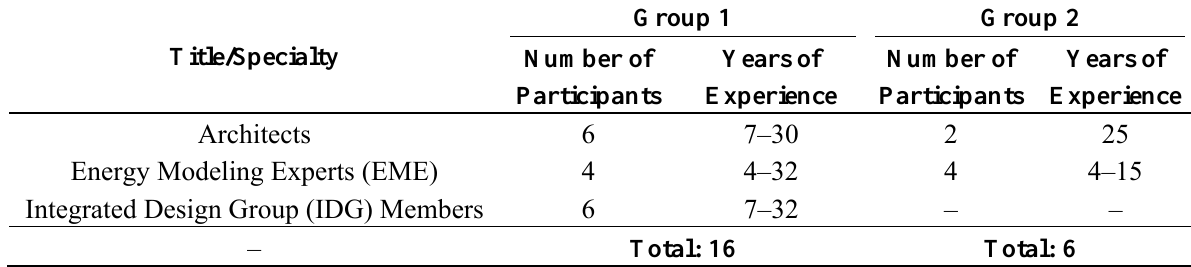
Table 3. Participants involved in requirements elicitation and validation